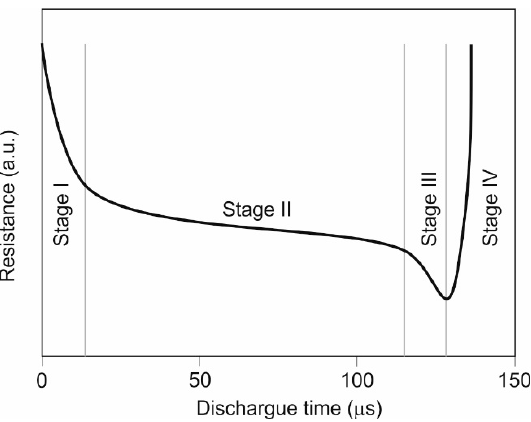
Figure 4. Evolution of the powder column electric resistance during EDC of metallic powders.